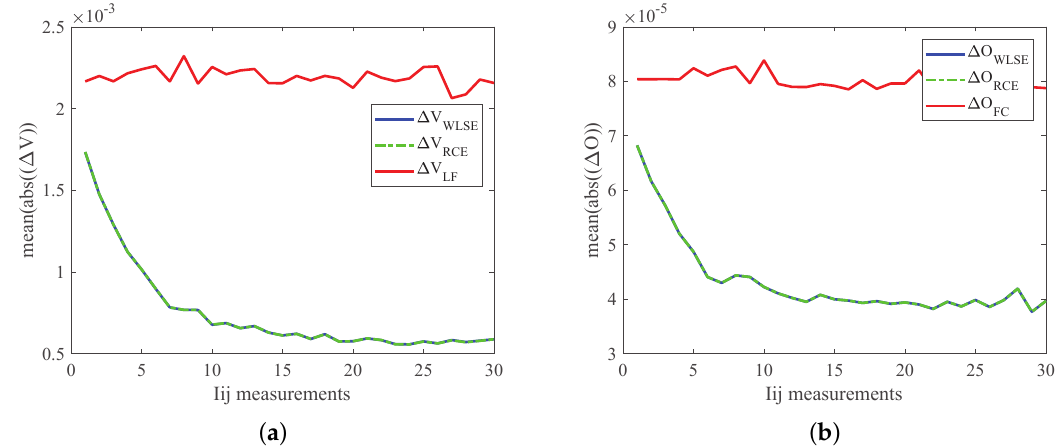
Figure 3. 85-bus system: ( a ) accuracy of voltage magnitudes; ( b ) accuracy of voltage phase angles (rad).